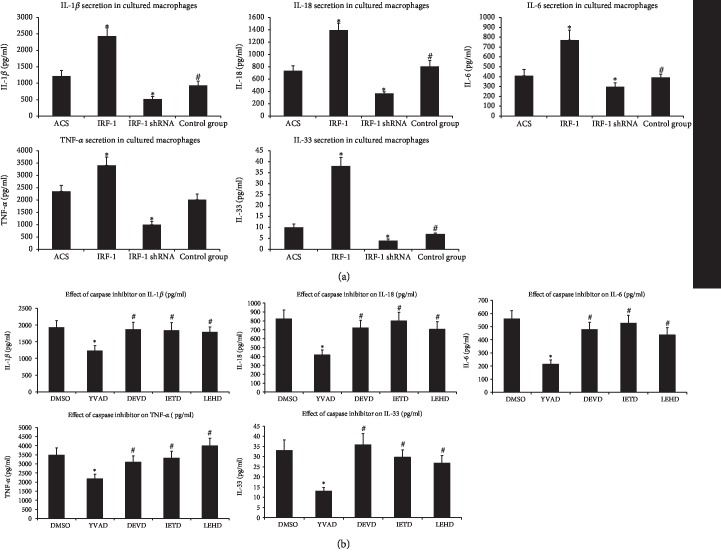
IRF-1 modulates the secretion of inflammation cytokines by macrophages. The secretion of cytokines was assayed by ELISA. (a) Macrophages were transfected with pGC-FU-IRF-1, IRF-1 shRNA, and control-shRNA; ACS group was cultured with PBS. Then, the cells were cultured with ox-LDL for 48 h. The IL-1β, IL-18, IL-6, IL-33, and TNF-α concentrations in the supernatants of the transfected macrophages were detected. ∗ indicates vs ACS and control shRNA group (∗p < 0.01). # indicates vs ACS group (#p > 0.05). (b) After transfected with pGC-FU-IRF-1, the cells were treated with DMSO or caspase inhibitors for 1 h and then stimulated with ox-LDL for 48 h. ∗ indicates vs DMSO group (∗p < 0.01). # indicates vs DMSO group (#p > 0.05).